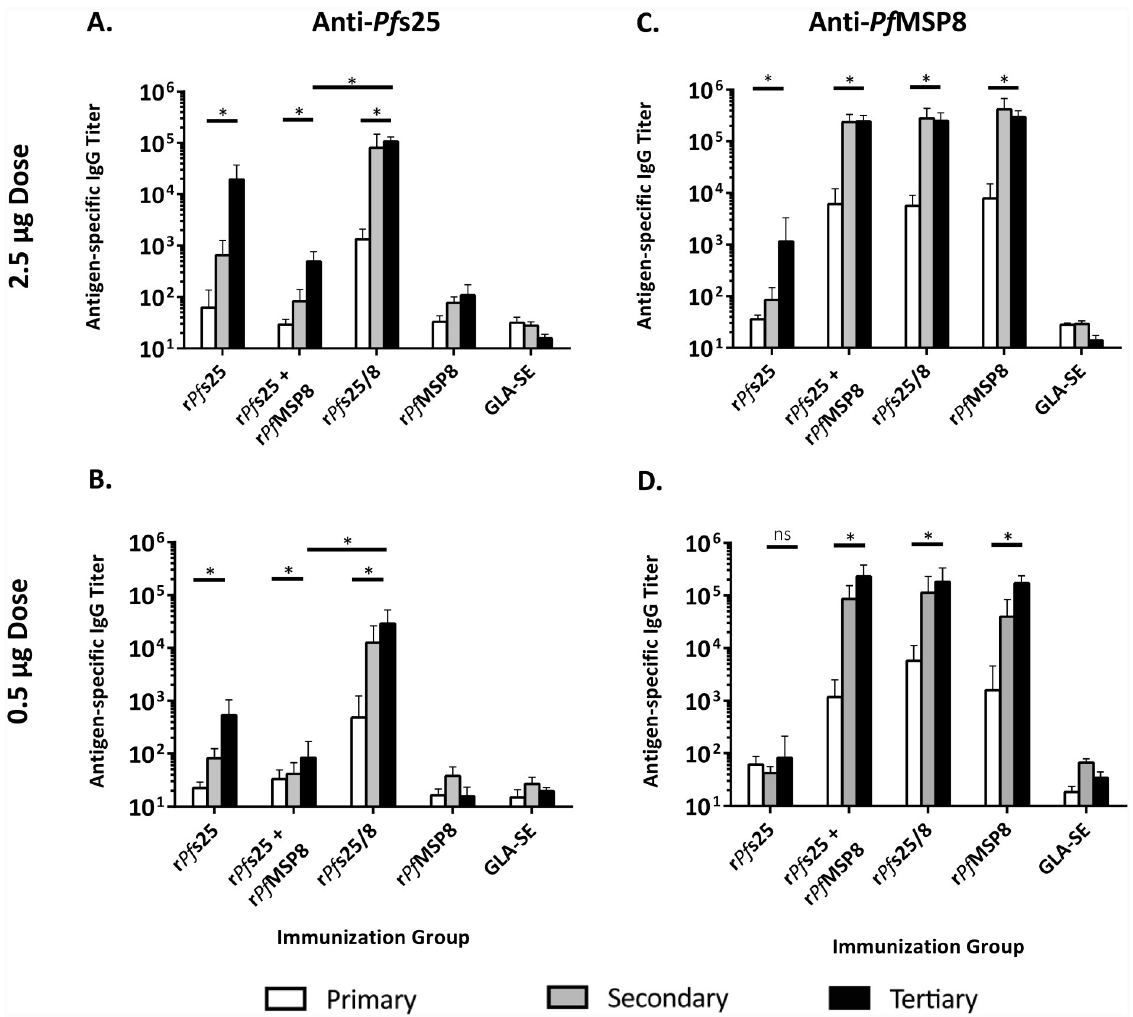
Fig 4. Antigen-specific IgG titers elicited by GLA-SE-based formulations. CB6F1/J sera collected 3 weeks following each subcutaneous immunization were analyzed for antigen-specific antibodies by ELISA using plates coated with r Pf s25 (A and B) or Pf MSP8 (C and D) (0.25 μ g/well). Graphs depict the mean IgG titers +/- standard deviation. Asterisks over horizontal lines within an immunization group indicate significant boosting of antigen-specific IgG titers over time (Friedman Test; P < 0.05 considered significant). Asterisks over horizontal lines comparing different immunization groups indicate significant differences between final titers achieved by those groups (Kruskal Wallis Test, P < 0.05 considered significant).